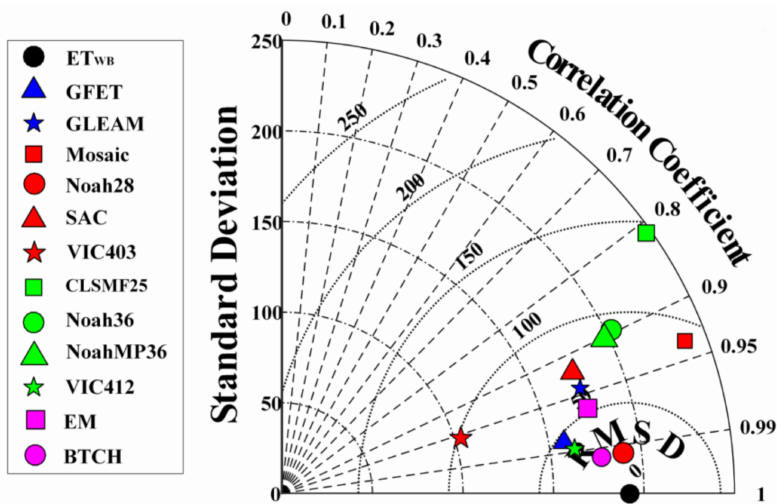
Figure 5. Comparison of annual BTCH-integrated, ensemble mean (EM), and ten parent evapotranspiration (ET) dataset with ET from water balance method from 1982 to 2011. There are 360 samples over the contiguous United